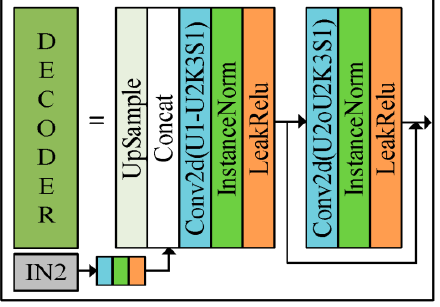
Figure 8. Decoder module.